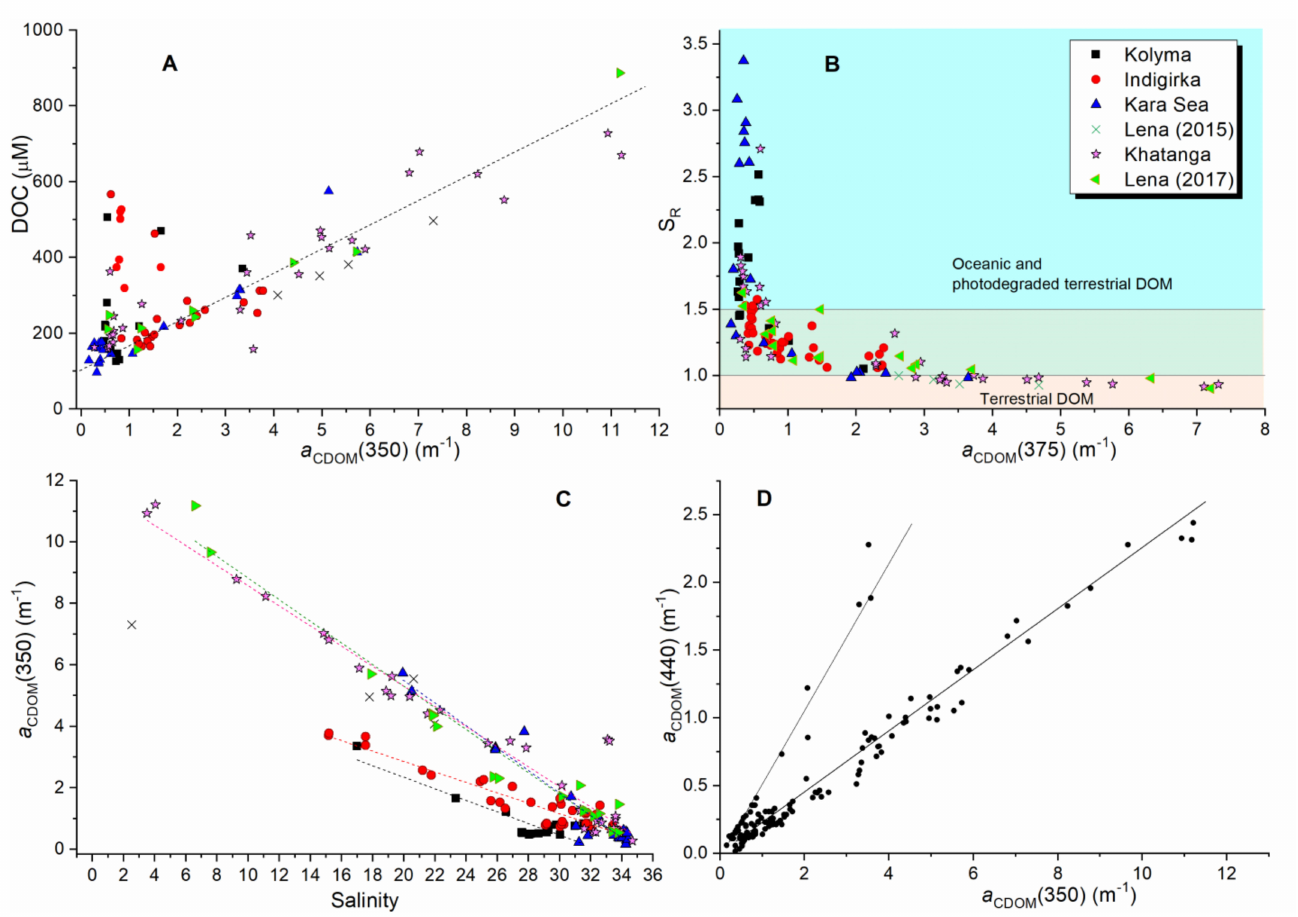
Figure 9. ( A )—DOC against absorption coefficient at 350 nm for the studied samples; ( B )—spectral slope ratio plotted against the absorption coefficient at 375 nm; ( C )— a CDOM (350) against salinity for the individual mixing zones; ( D )— a CDOM (440) plotted against a CDOM